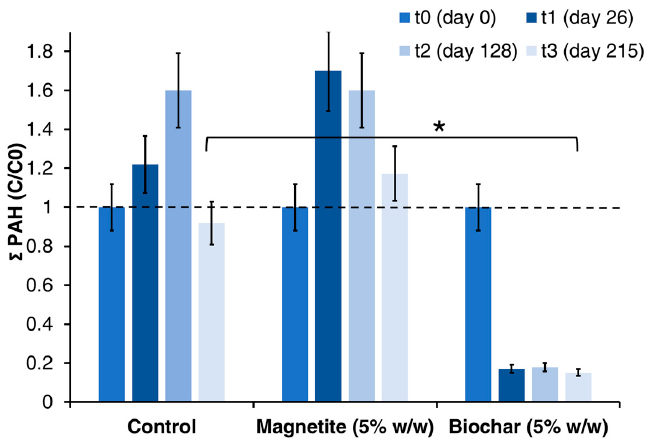
Figure 5. The relative concentration of total priority PAH detected in the soil over time in the different treatments. Error bars represent the SE of replicated samples. Significant differences were determined by two-tailed Student’s t -tests (* corresponds to p < 0.05).